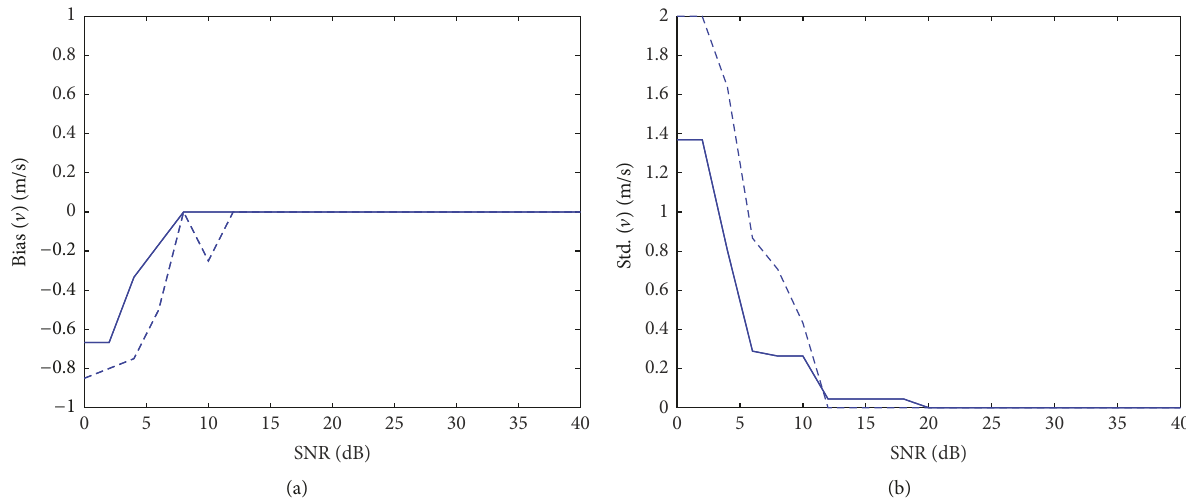
Figure 4: Bias (a) and standard deviation (b) of velocity estimates for the 4-PRT (solid line) and 2-PRT (dashed line) with CSR = − 20dB using the